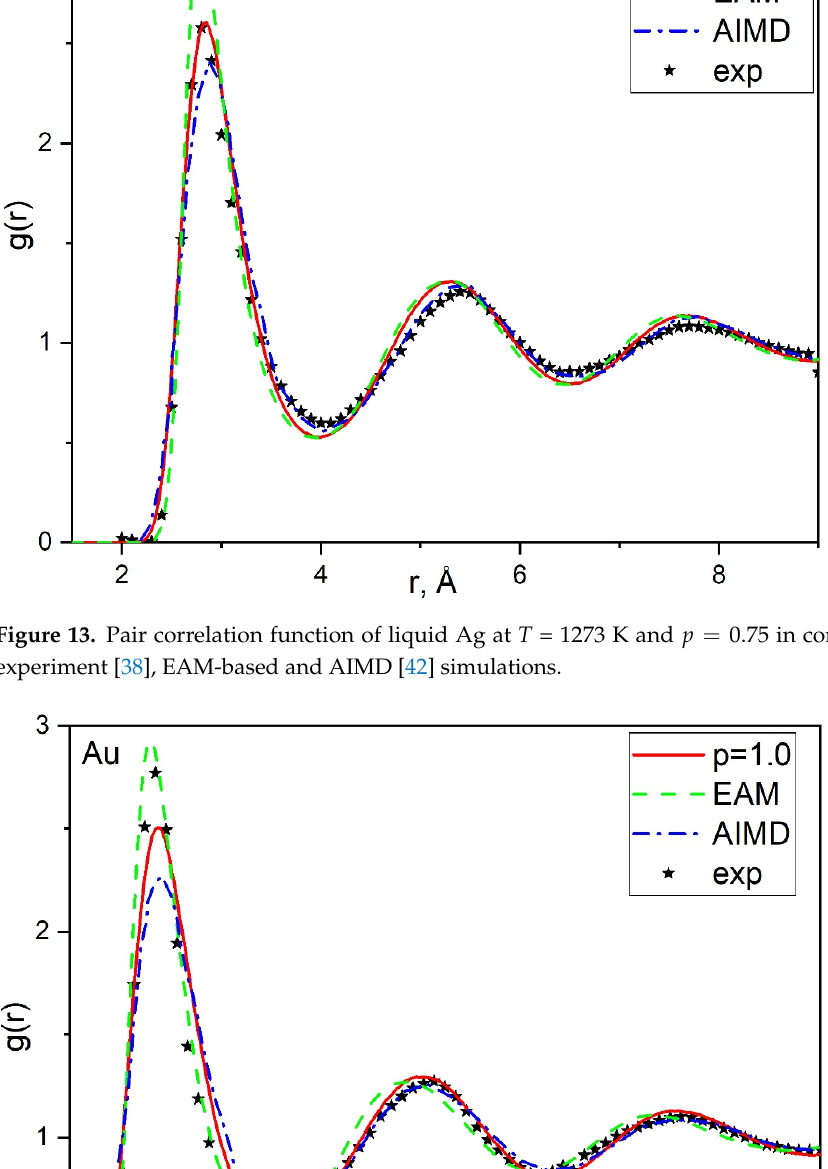
Figure 12. Pair correlation function of liquid Cu at T = 1423 K and experiment [38], EAM-based and AIMD [42] simulations.